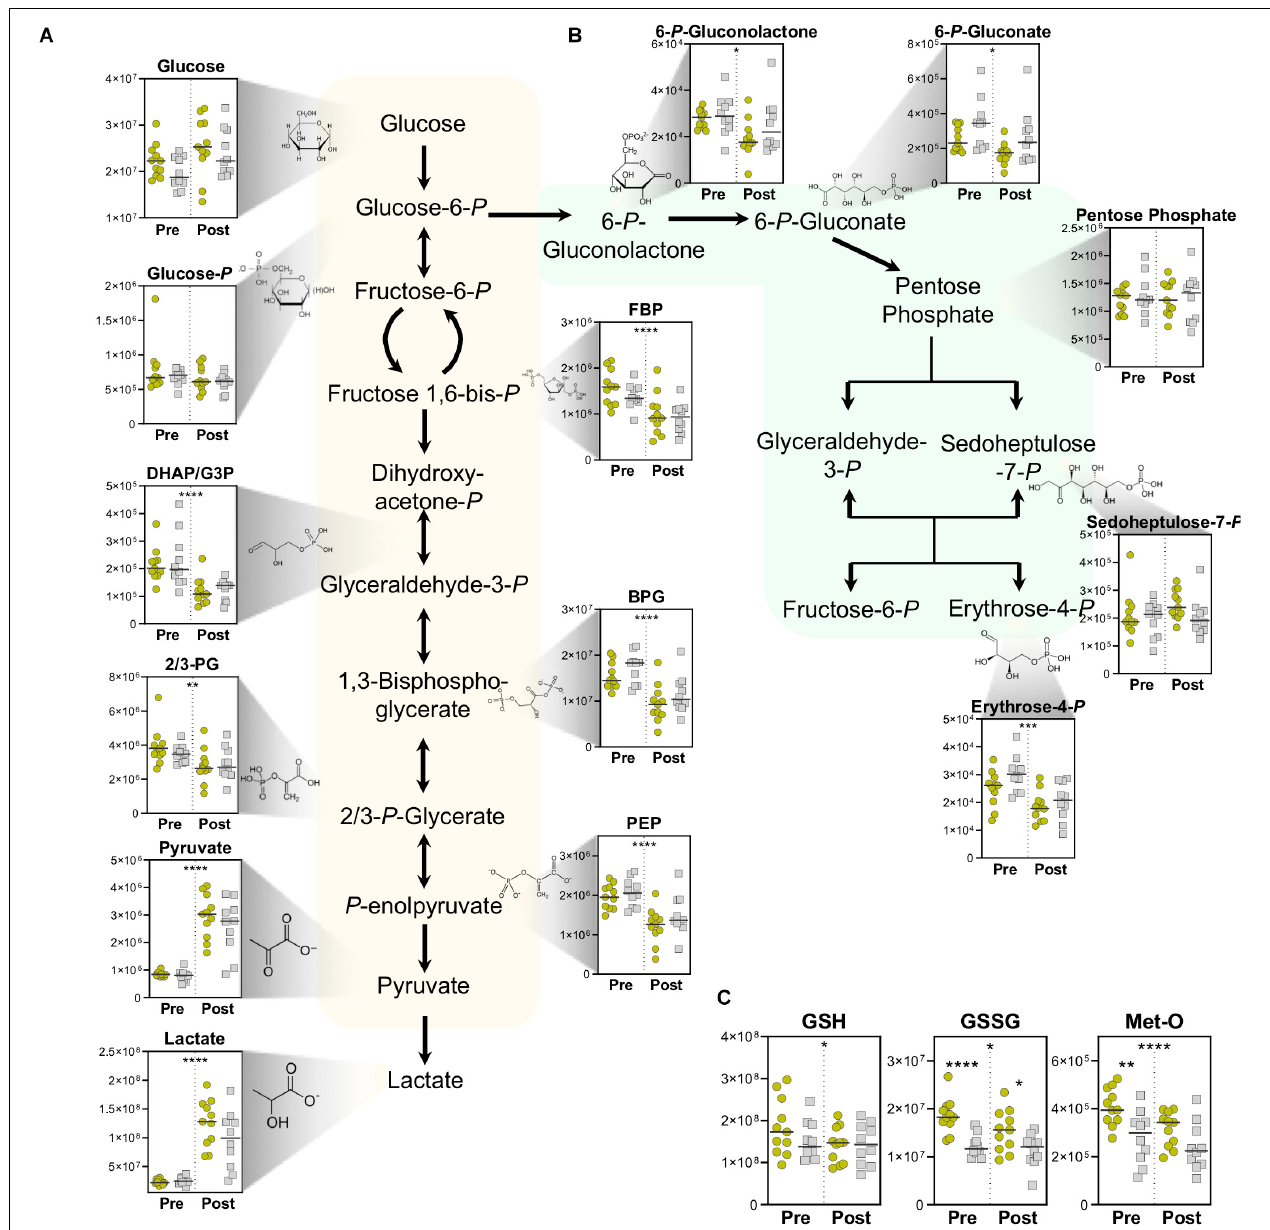
FIGURE 3 | Energy and Redox Metabolism. Metabolite abundances ( y -axis, Peak Area (AU)) are plotted for (A) Glycolysis, (B) pentose phosphate pathway, and (C) Reduced (GSH) and oxidized (GSSG) glutathione, as well as oxidative-stress derived methionine sulfoxide (Met-O). Samples from the Gold ( ◦ ) and Silver ( (cid:3) ) groups are shown Pre and Post exercise test (divided by a dotted line). p -values from a two-tailed paired T -test of comparisons between the Pre and Post time points using combined Gold/Silver group values are shown above the dashed line. p-values from a two-tailed unpaired homoscedastic T -test comparing the Gold and Silver groups at each time point are shown on the respective side of the dashed line. * p < 0.05; ** p < 0.01; *** p < 0.001; **** p <